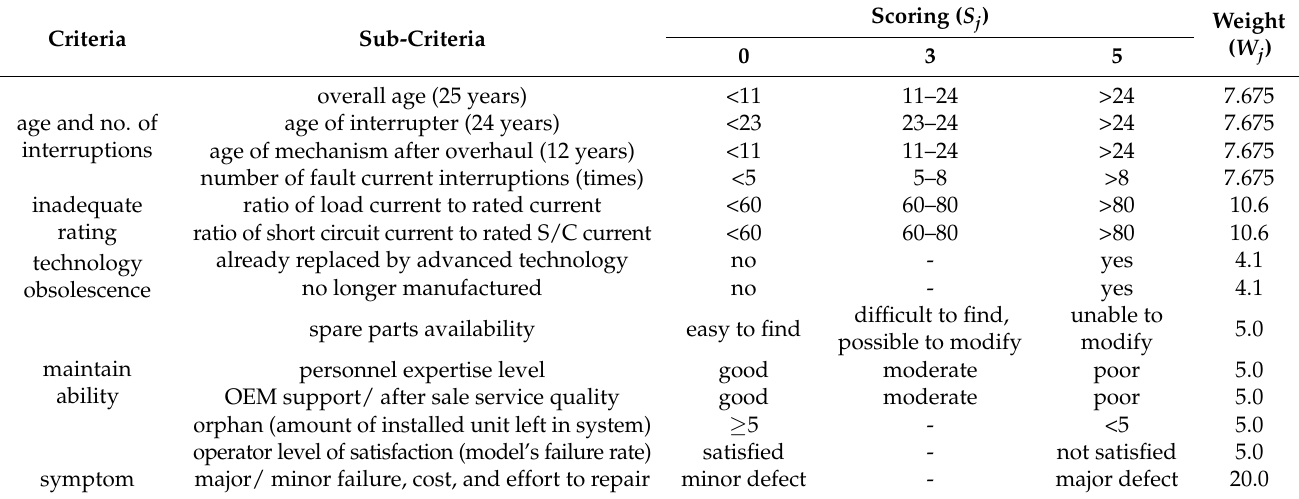
Table 4. Criteria and weighting–scoring method for the %RI evaluation of